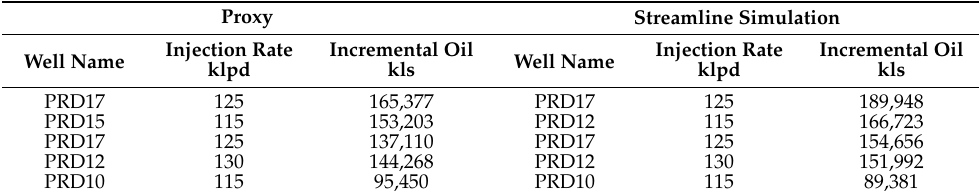
Table 11. Proxy performance on the waterflood blind test.